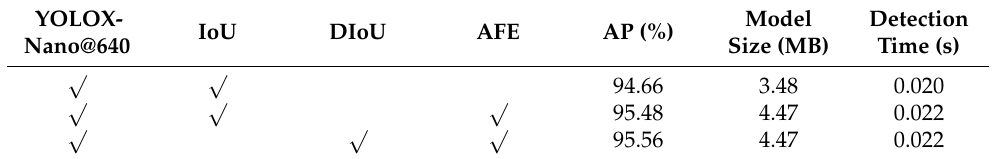
Figure 10. PR curves for the six lightweight detection models.